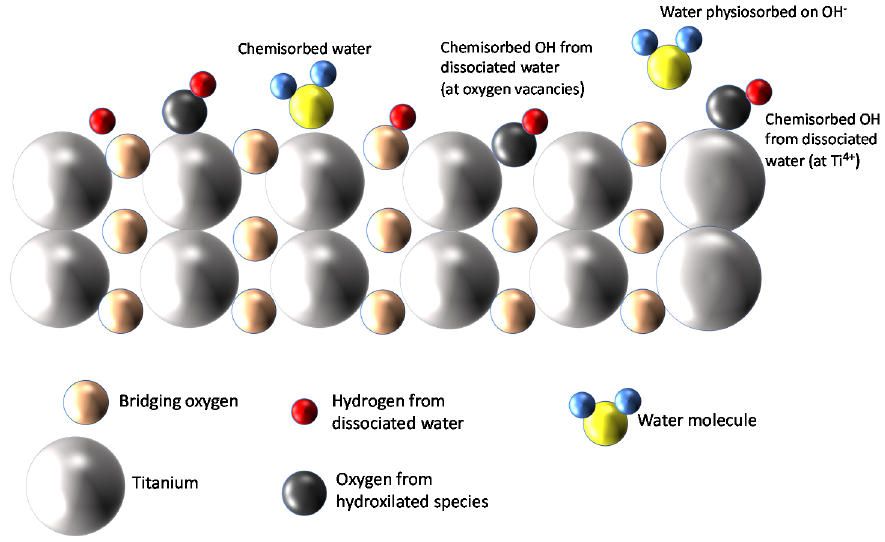
Figure 1. Water adsorption on TiO 2 [14].